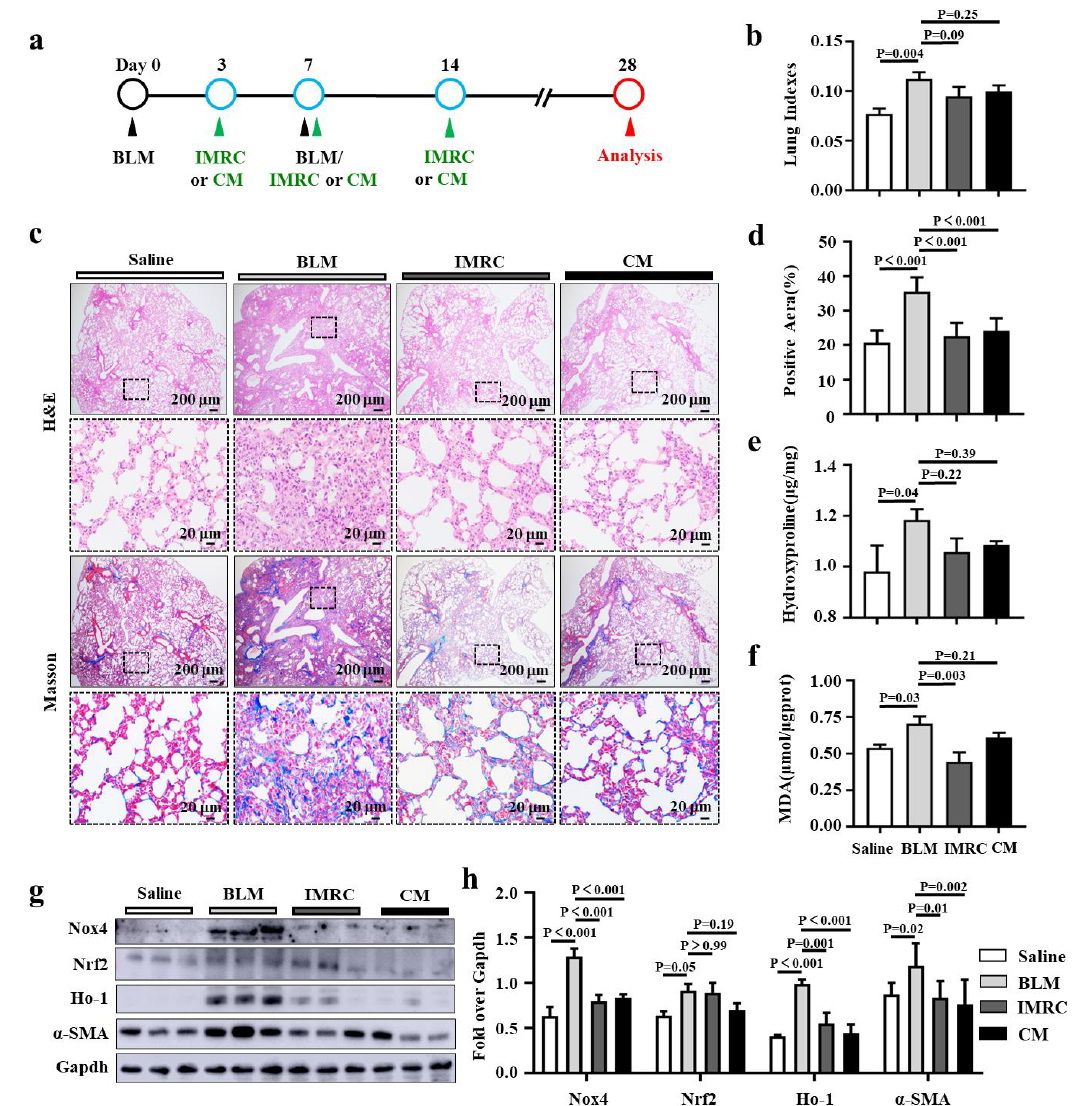
Figure 4. hESC-MSC-IMRCs and hESC-MSC-IMRC-CM inhibit the development of pulmonary fibrosis in mice. ( a ) Schematic illustration shows the experimental workflow for the treatment of the BLM-induced IPF mouse model at an early stage of PF development. C57BL/6 mice were challenged with BLM via the laryngotracheal route at day ( d ) 0 and d7. A 200 µ L sample of saline containing 3 × 10 6 cells of hESC-MSC-IMRCs and 200 µ L of hESC-MSC-IMRC-CM were delivered via the tail vein injection at d3, d7, and d14 after the first dose of BLM challenge. The lung tissues were harvested at d28 for analysis. ( b ) The effect of hESC-MSC-IMRC-CM on lung index (ratio of lung/body weights). ( c ) Representative histochemical images of H&E and Masson staining demonstrate that both hESC-MSC-IMRC-CM and hESC-MSC-IMRCs can ameliorate the pathogenesis of pulmonary fibrosis (H&E staining) with ECM deposition (Masson staining) compared to animals challenged with BLM alone. ( d ) Histological analysis of the fibrotic area. ( e , f ) The levels of hydroxyproline (Hyp) and malondialdehyde (MDA) contents. ( g ) Representative immunoblots show a reduction in indicated molecules of oxidative stress-signaling pathways and α -SMA in BLM-induced fibrotic lung administrated with hESC-MSC-IMRC-CM or hESC-MSC-IMRCs compared to the lungs of BLM-challenged mice alone. ( h ) The relative levels of Nox4, Nrf2, Ho-1 and α -SMA proteins as evaluated by a densitometric analysis in ( g ). Data in ( b , d – f , h ) represent mean ± SD of three independent experiments (N = 3), as analyzed by GraphPad prism two-way ANOVA Tukey’s multiple comparisons test. Scale bars in ( c ), 200 µ m in the first and third panels, 20 µ m in the second and fourth